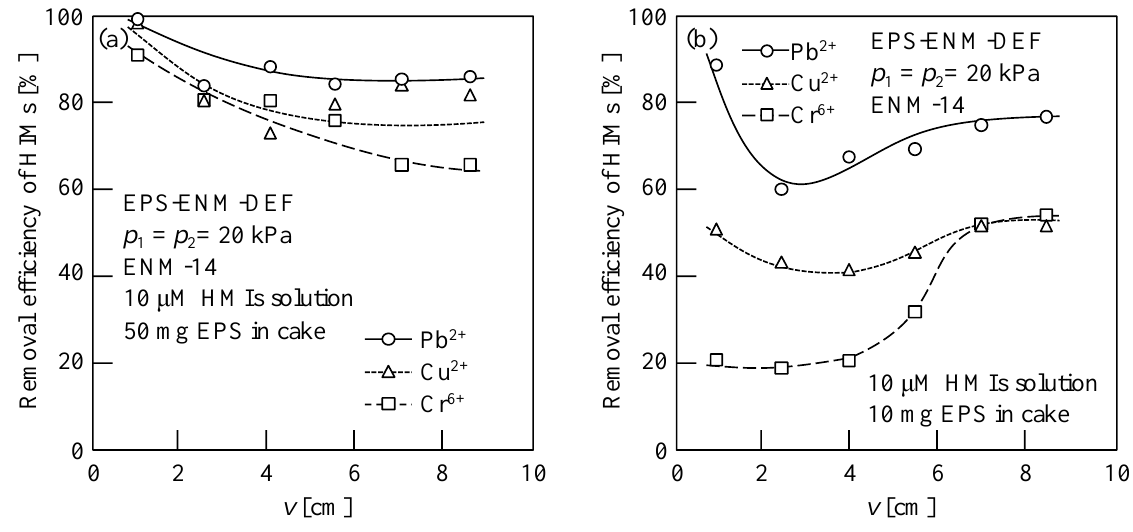
Figure 12. HIM removal efficiencies during the EPS–ENM–DEF process on ENM-14 for ( a ) 50 mg and ( b ) 10 mg EPS filter cakes. First stage: concentration and recovery filtration of 1.0 and 0.2 g/L EPS solutions (50 mL) at p 1 = 20 kPa to give EPS filter cakes with masses of 50 and 10 mg, respectively. Second stage: filtration of 10 µ M solutions (180 mL) of the desired HIM (Pb 2+ , Cu 2+ , or Cr 6+ , pH 6.2–6.7) at p 2 = 20 kPa. v is the cumulative filtrate volume per unit membrane area.